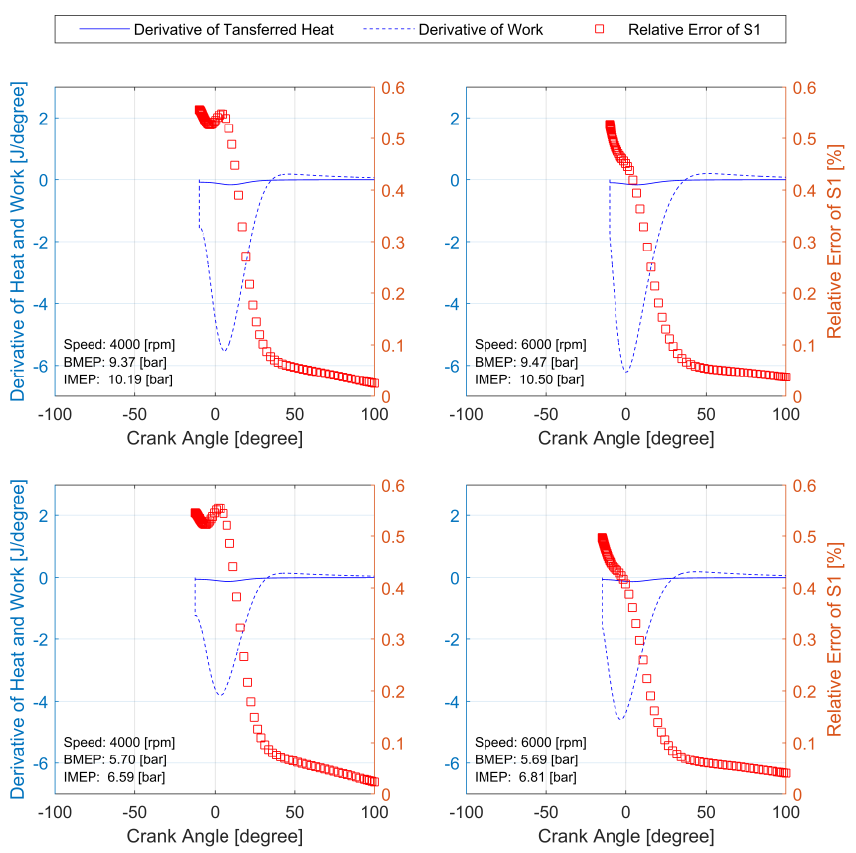
Figure 11. Derivative of heat transferred to wall and pressure-volume work in unburned zone together with the relative error of simplification S1.